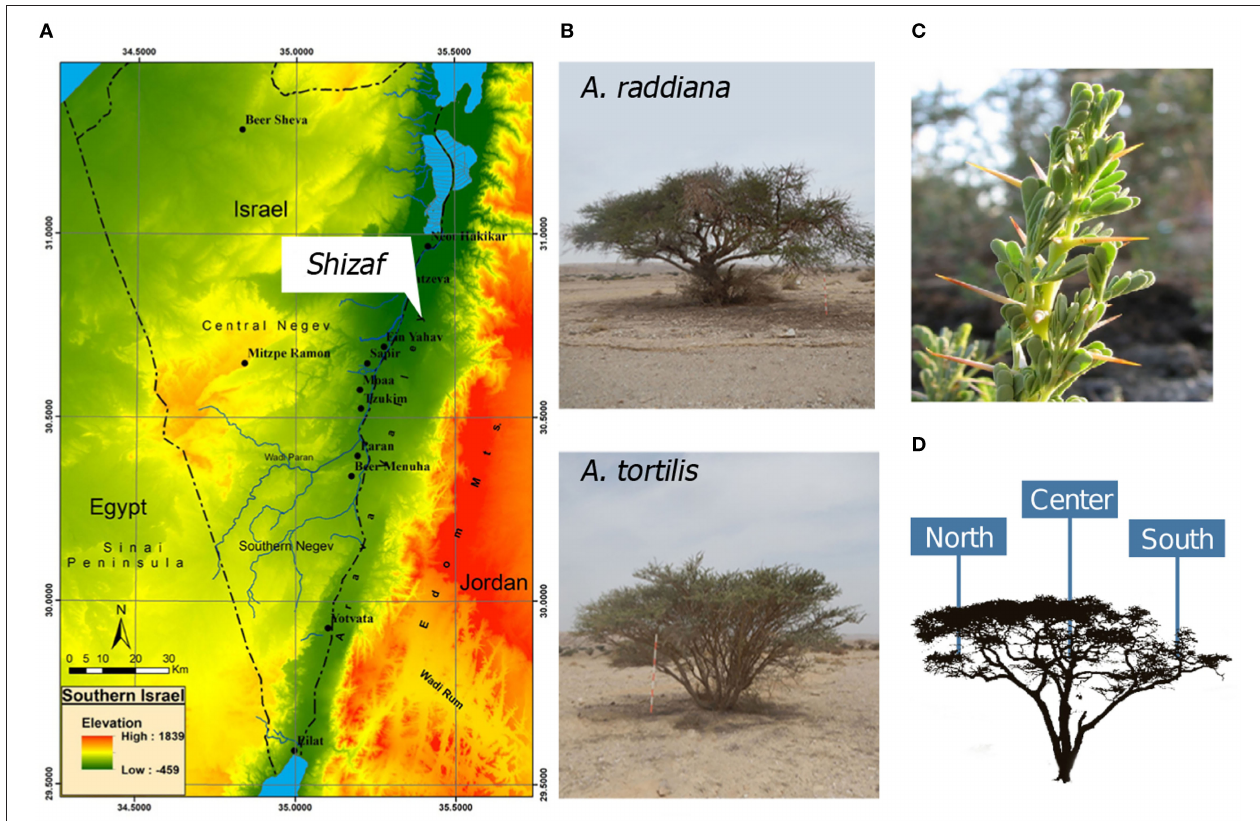
FIGURE 1 | (A) Southern Israel topography map showing the study site, Wadi Shizaf, and (B) acacia trees ( A. raddiana and A. tortilis ) sampled monthly during 2015. In each month, (C) leaf samples were collected from the (D) north, center, and south sides of the